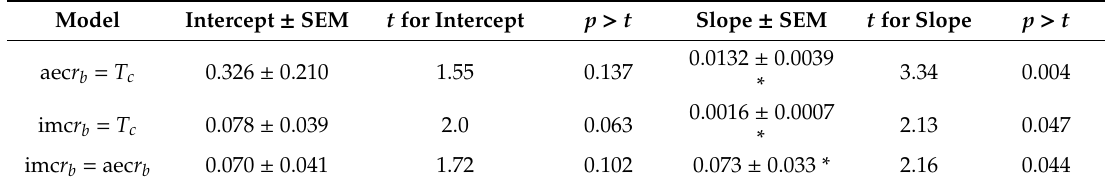
Table 5. Intercepts and slopes (±SEM) for regression equations fitting the models in Equations (1) and (2).